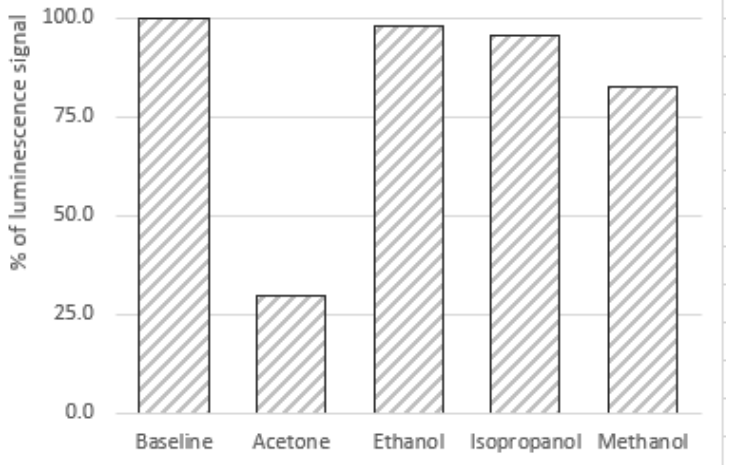
Figure 10. Effect of the assayed interferents on the luminescence of the sensing phase. The assayed concentrations were 157 ppm of acetone, 781 ppm of isopropyl alcohol, 757 ppm of methanol, and 789 ppm of ethanol.